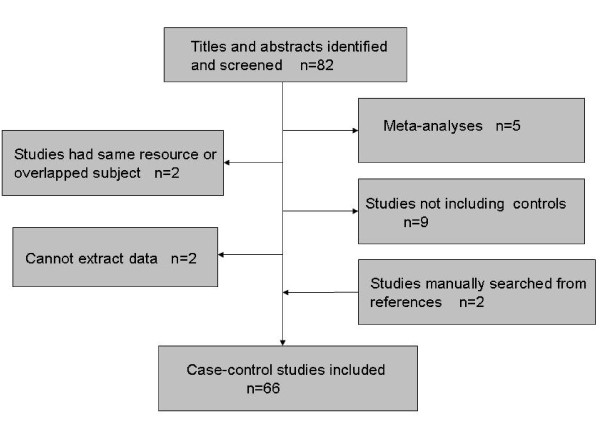
Flow chart of the eligible study selection process.